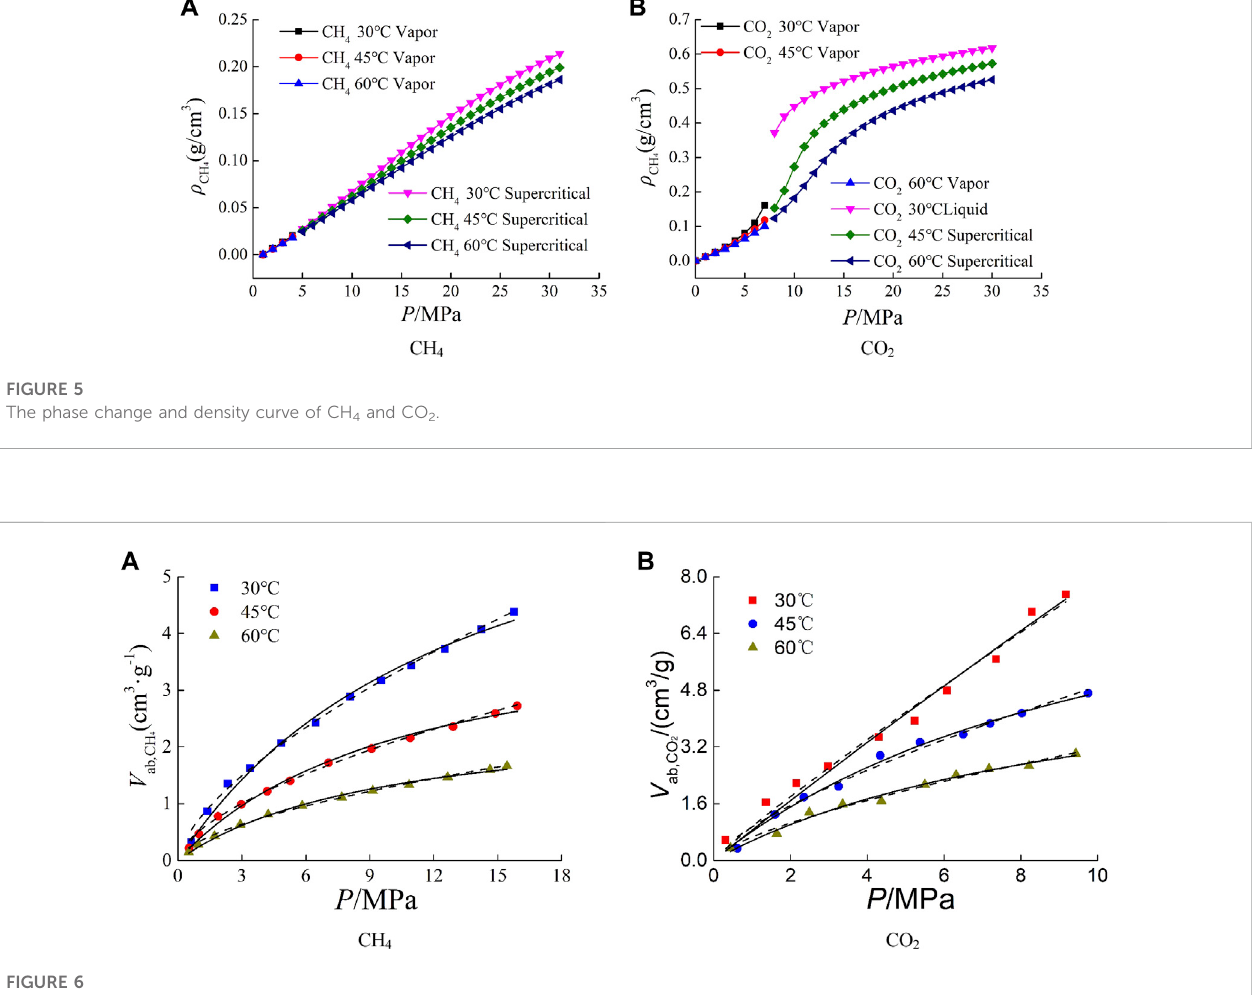
FIGURE 6 The absolute adsorption isotherm of shale of Yanchang Formation.